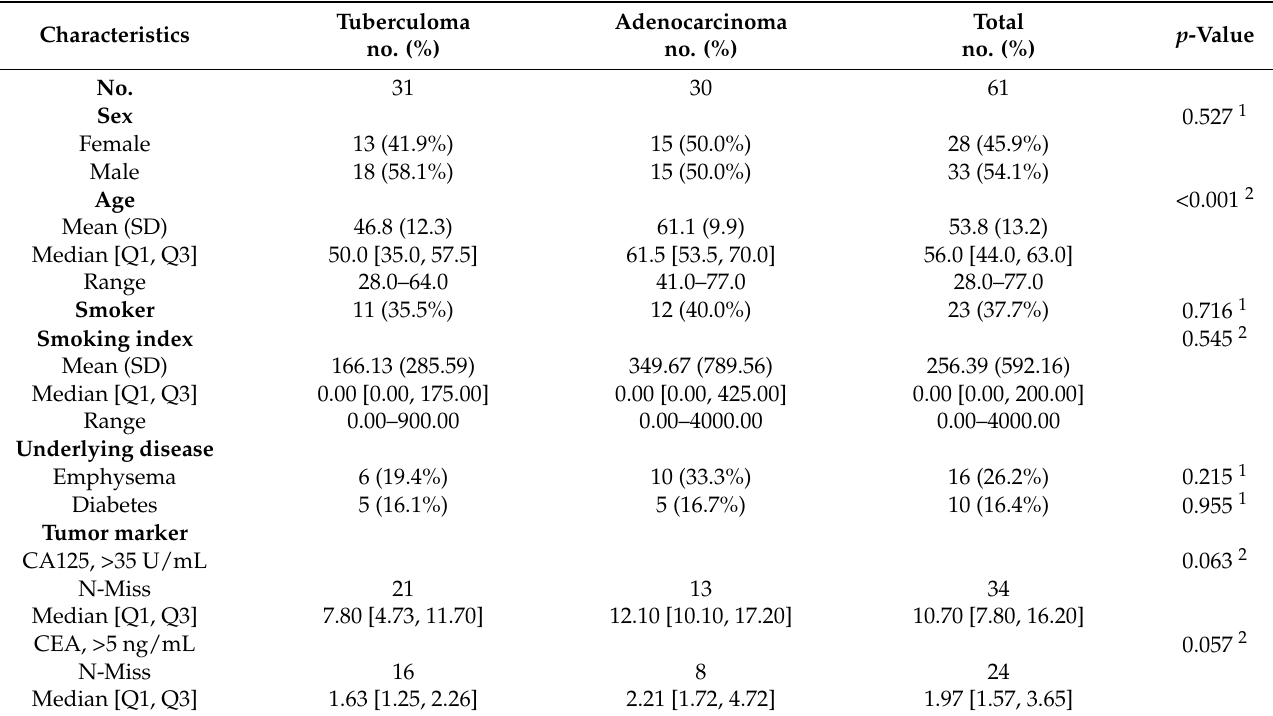
Table 1. Clinical characteristics and tumor markers in patients with tuberculoma vs. those with adenocarcinoma.